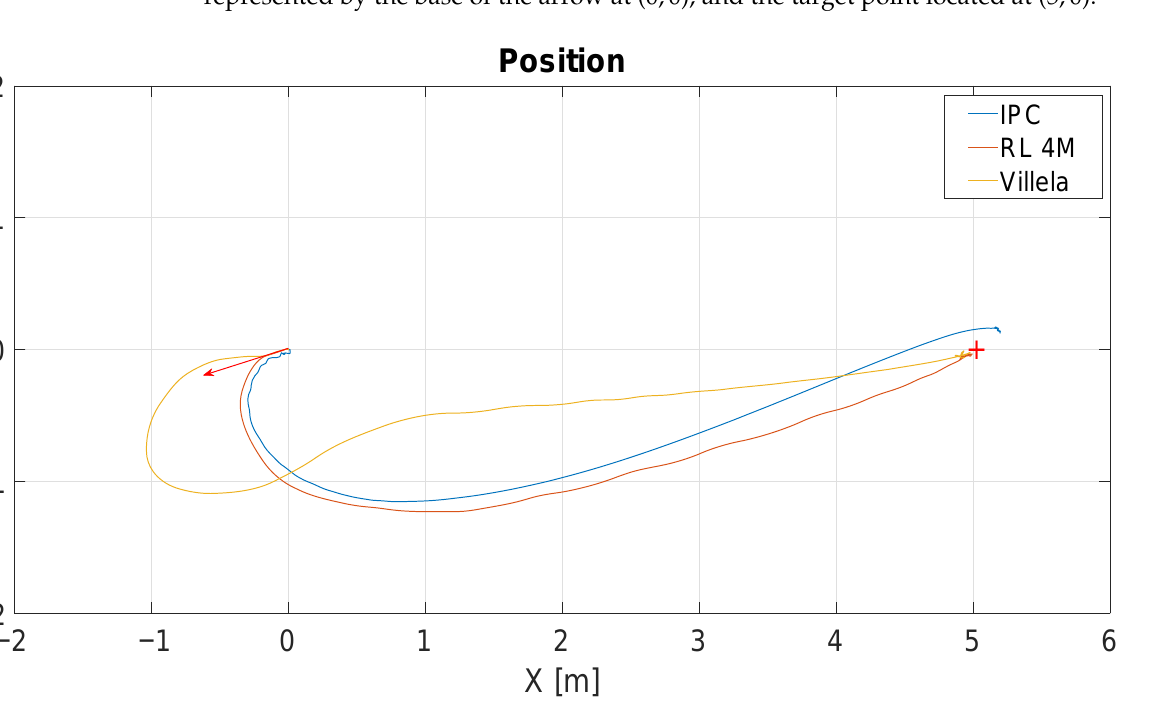
Figure 11. Obtained trajectories for each control algorithm (Villela, IPC and